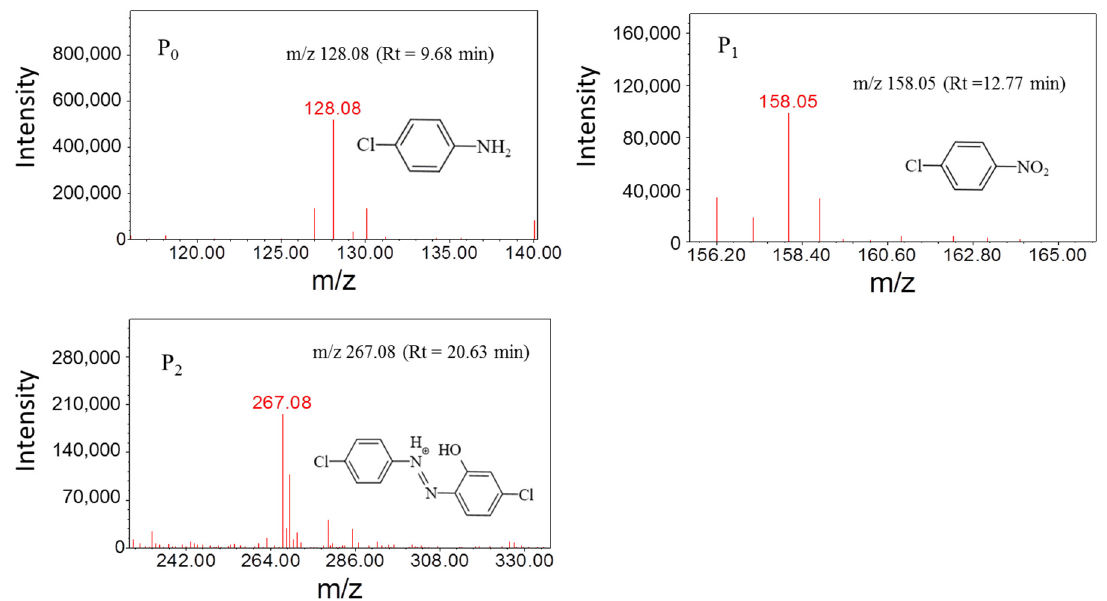
Figure 7. Mass spectra of PCA and its degradation products. Experimental conditions: [PCA] = 20 mg/L, [PDS] = 2.4 mM, [MnFe 2 O 4 ] = 1.3 g/L.